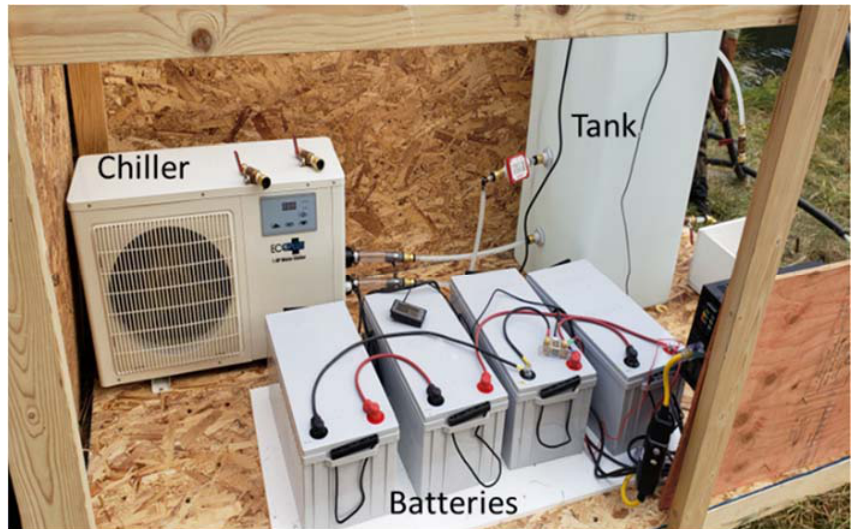
Figure 5. Picture of the chiller, batteries, and water storage tank used in the experiments. The prototype thermal refugia system is powered by a PV system. The total electrical power required to operate the prototype thermal refugia system is approximately 0.64